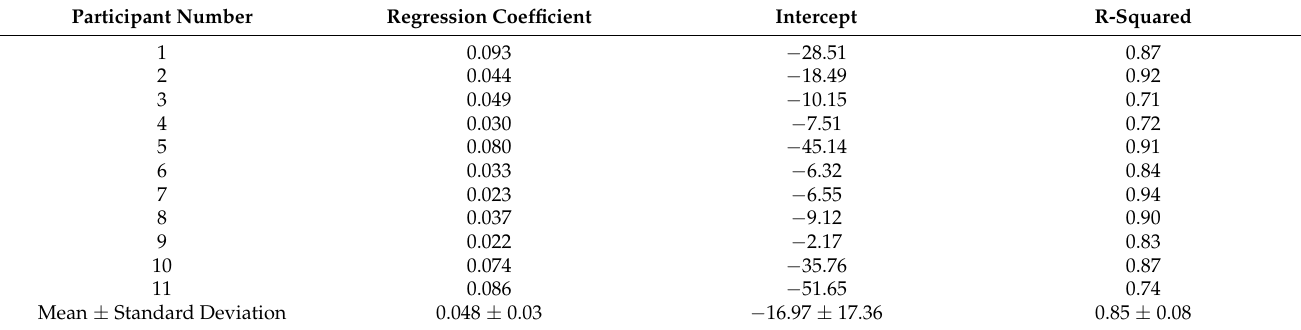
Table A2. Individual calibration